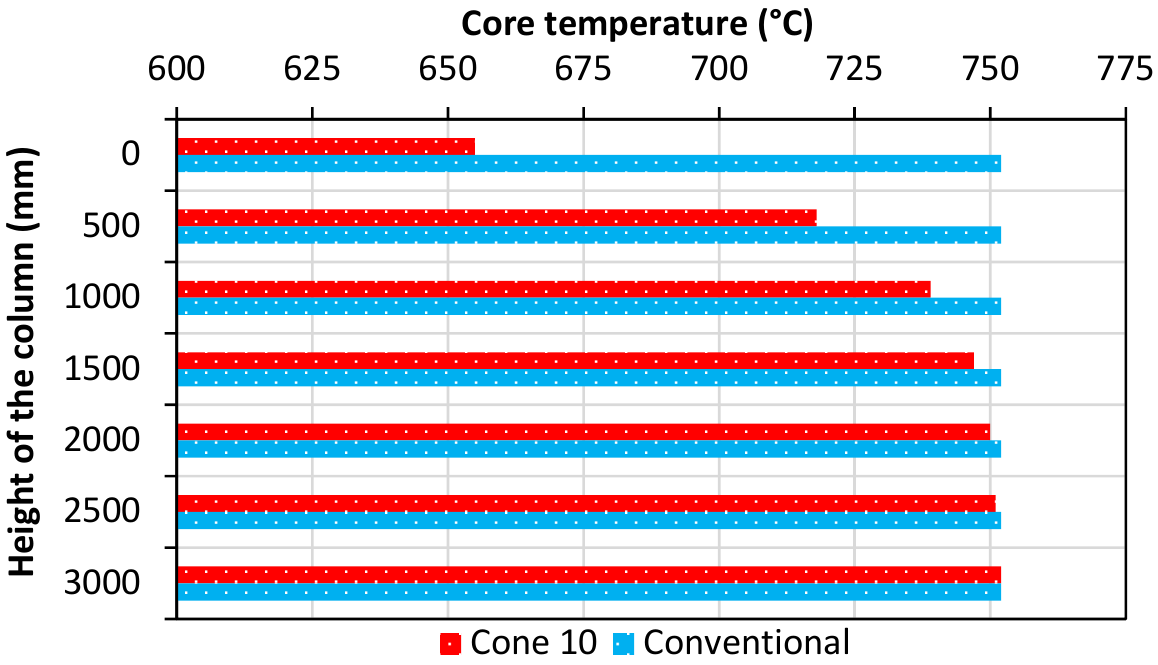
Figure 9. Heat dissipation of the column specimen with cone 10 and the conventional column.